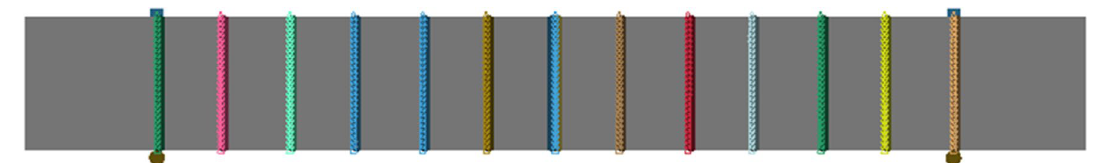
Fig. 9 Thirteen sections at 250